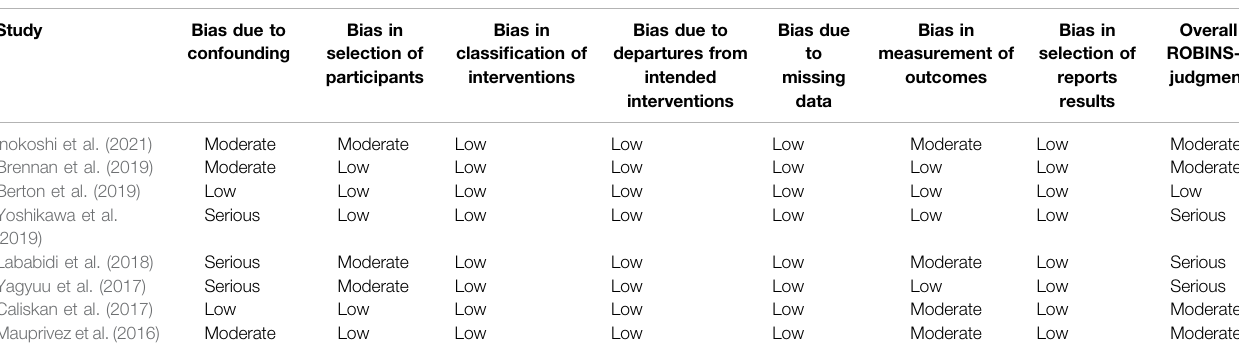
TABLE 4 | Risk of bias analysis for included studies using ROBINS-1